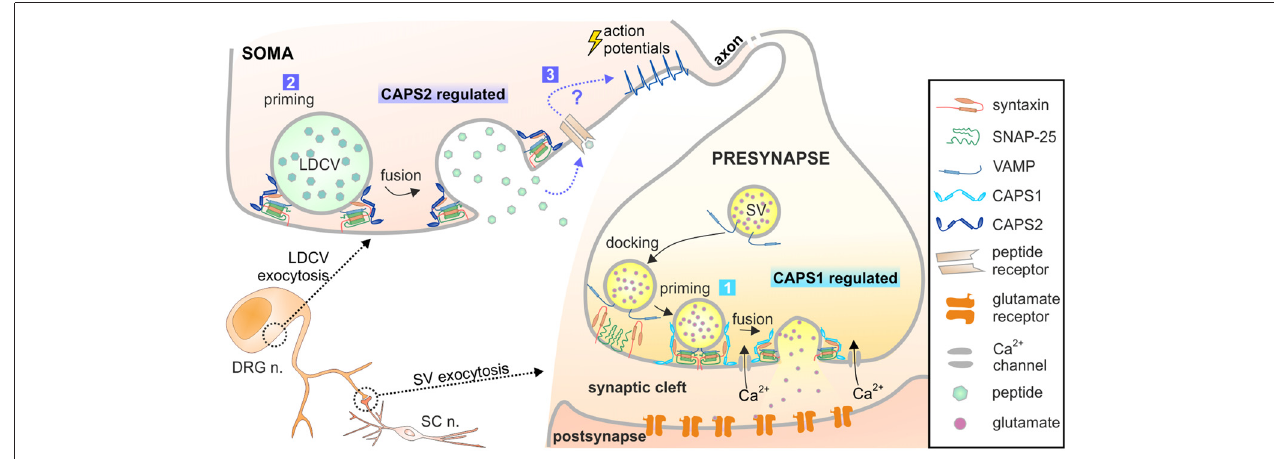
FIGURE 8 | Model of CAPS1 and CAPS2 function in DRG neurons. Our data suggest that 1. SV exocytosis is promoted by CAPS1 and 2. LDCV exocytosis is mediated by CAPS2 most likely by enhancing priming. 3. Peptidergic cargo released by LDCVs binds to its associated receptor and indirectly induces SV fusion by a yet unknown mechanism. The peptides might act in an autocrine pathway as depicted here or in a paracrine pathway and thereby affect synaptic transmission of many neighboring